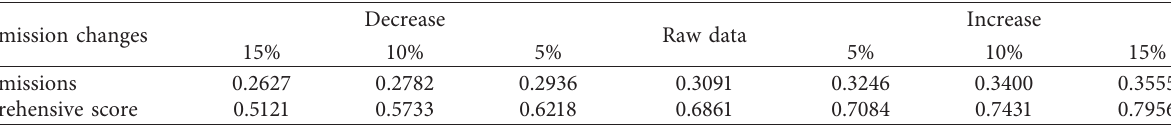
Table 8: Impact of CO 2 emissions on vulnerability.